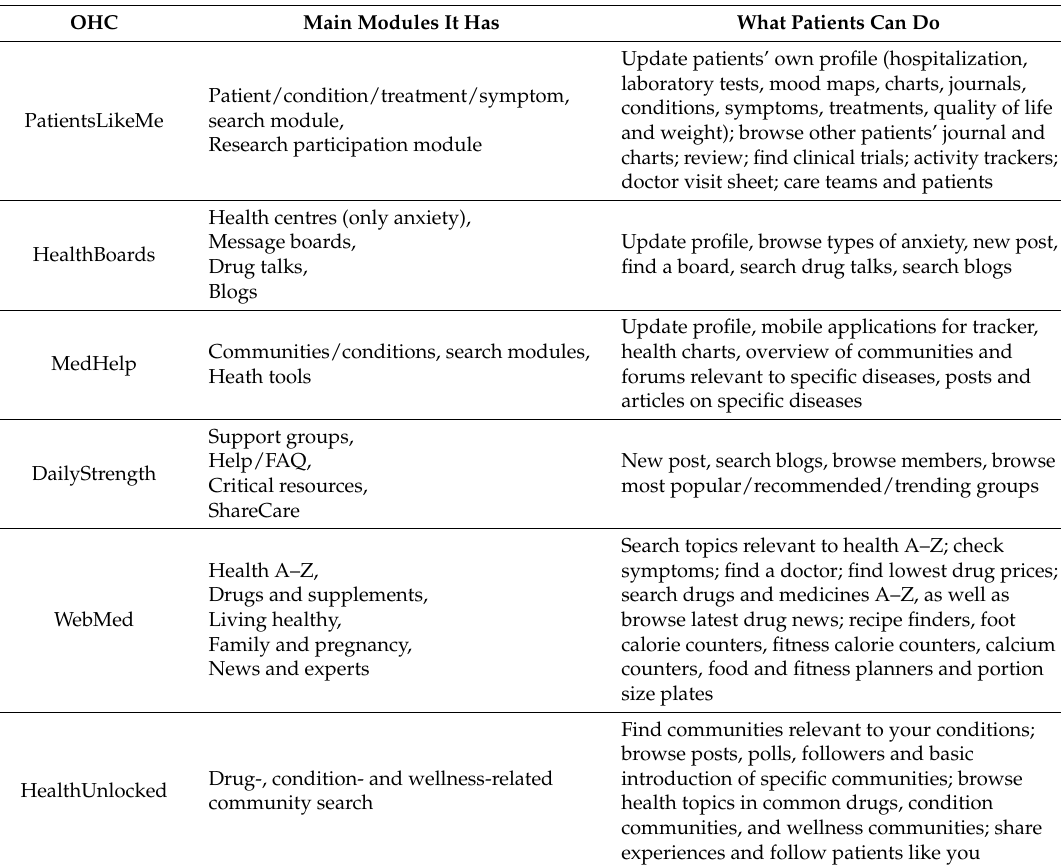
Table 2. Summary of the effective functions in six typical